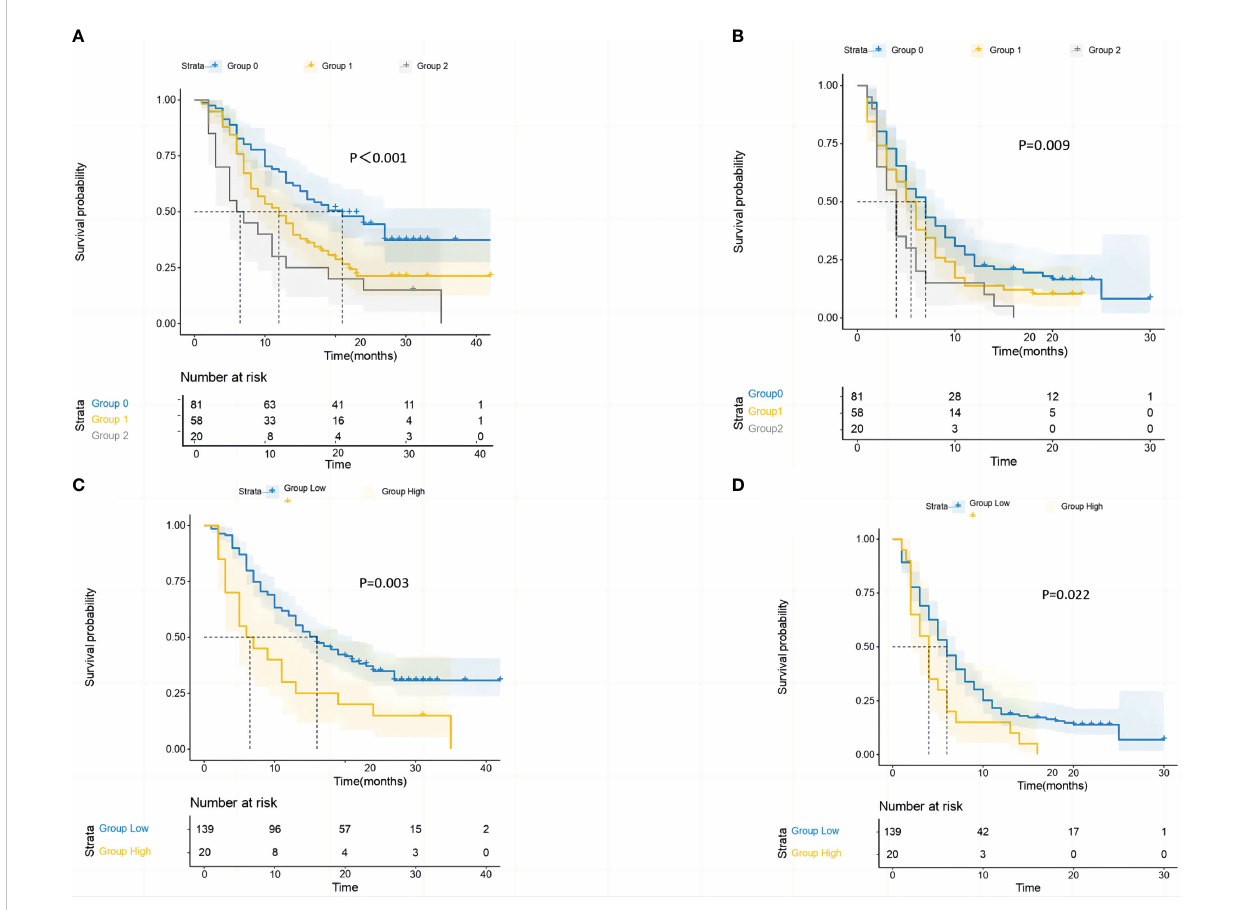
FIGURE 4 The study conducted survival probability analyses of OS and PFS based on the GRIm-Score estimated by a three-category risk assessment scale (A , B) and the original Bigot ’ s group (C , D) . The results are presented in the article. OS, overall survival; PFS, progression-free survival; GRIm-Score, Gustave Roussy Immune